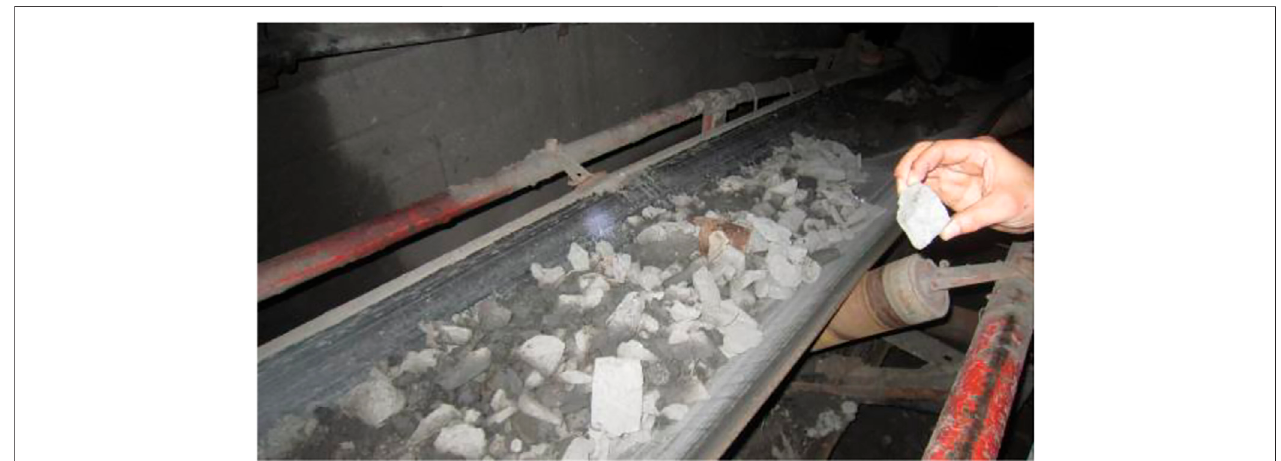
FIGURE 14 | Transportation of fi lling gangue.